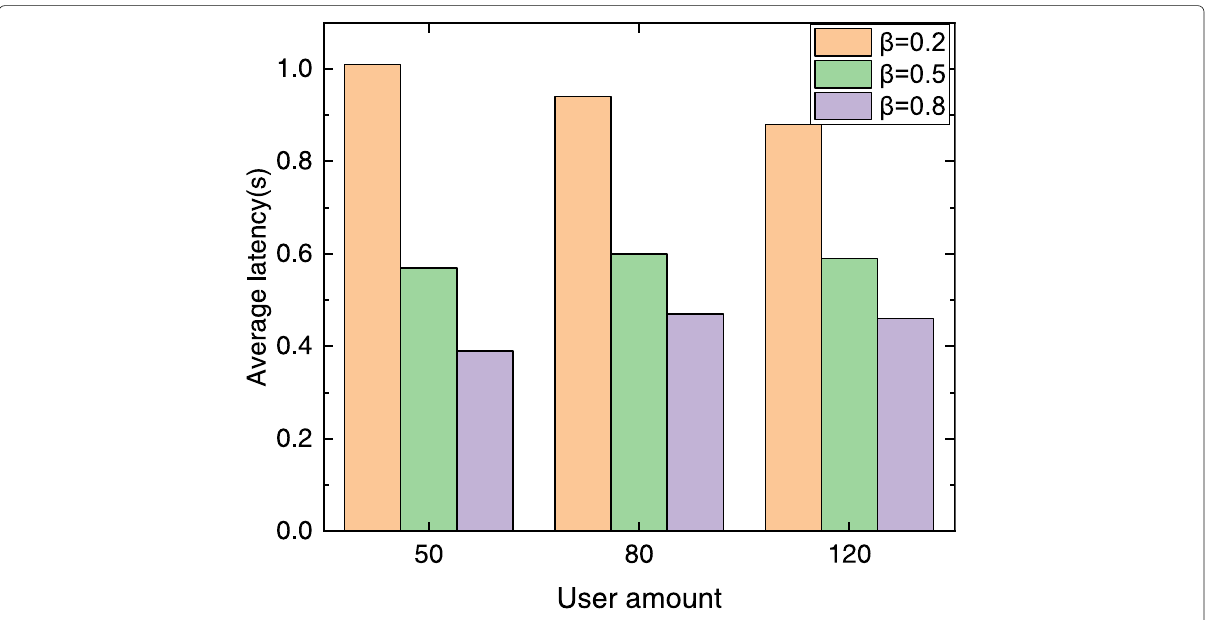
remaining power of the user’s equipment is small and the task is not sensitive to latency, like image recogni- tion, then the value of β can be set closer to 0. On the contrary, if the user’s device is fully charged and many tasks are delay-sensitive, such as online games, β can be set closer to 1, so that the user can get a